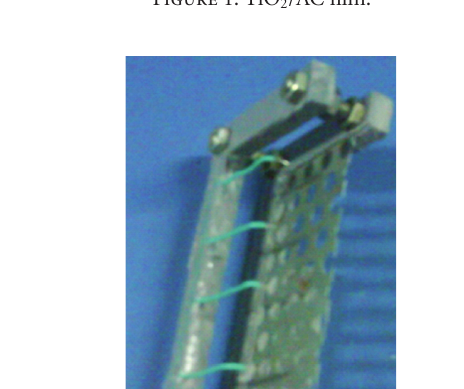
Figure 1: TiO 2 /AC film.